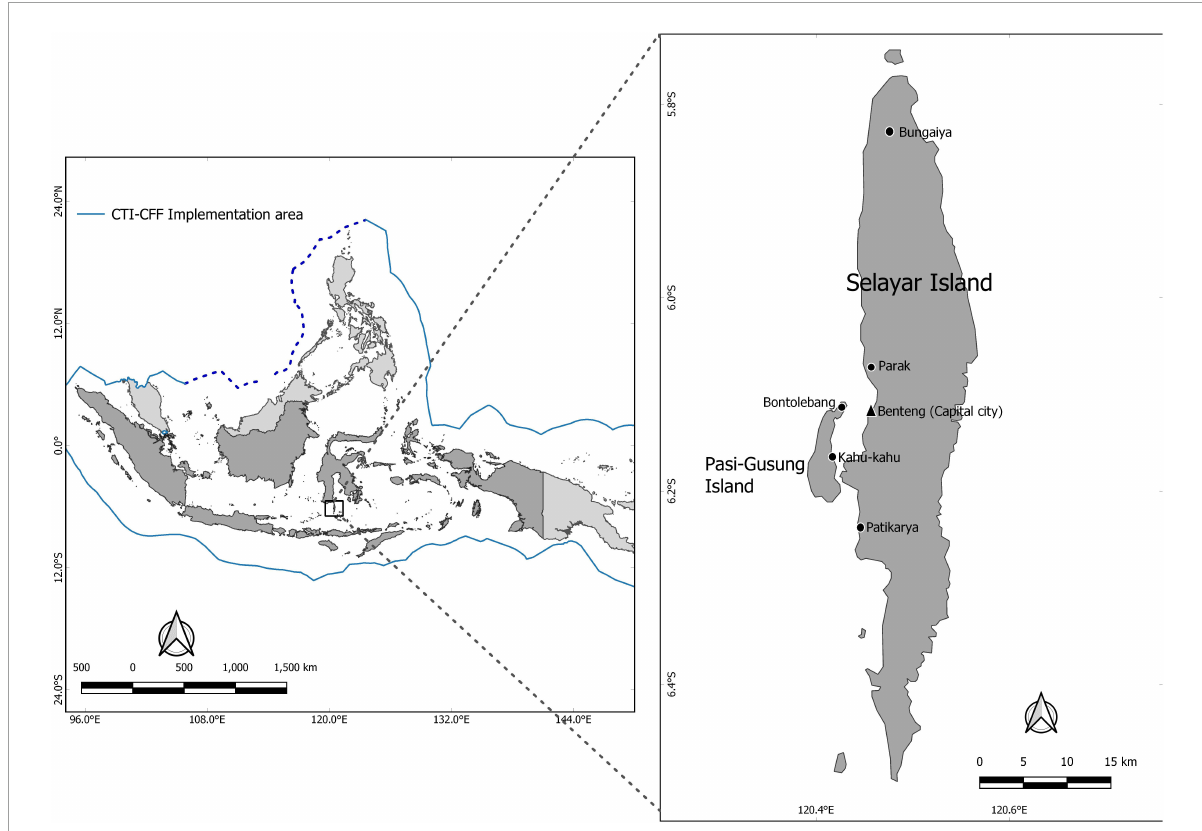
FIGURE1 The Coral Triangle, Selayar Island and villages of the community